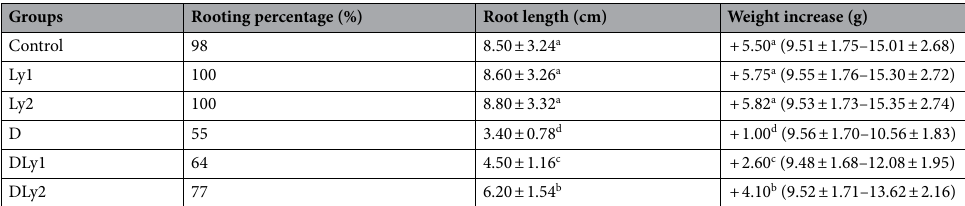
Table 1. Influences on selected growth parameters in A. cepa exposed to dithane and lycopene. Control: tap water, Ly1: 215 mg/L lycopene, Ly2: 430 mg/L lycopene, D: 500 mg/L dithane, DLy1: 500 mg/L dithane + 215 mg/L lycopene, DLy2: 500 mg/L dithane + 430 mg/L lycopene. Lowercase letters in the same column indicate statistical significance between the means (p < 0.05). For rooting percentage and weight gain, 50 bulbs were used; for root elongation, ten bulbs were used in each